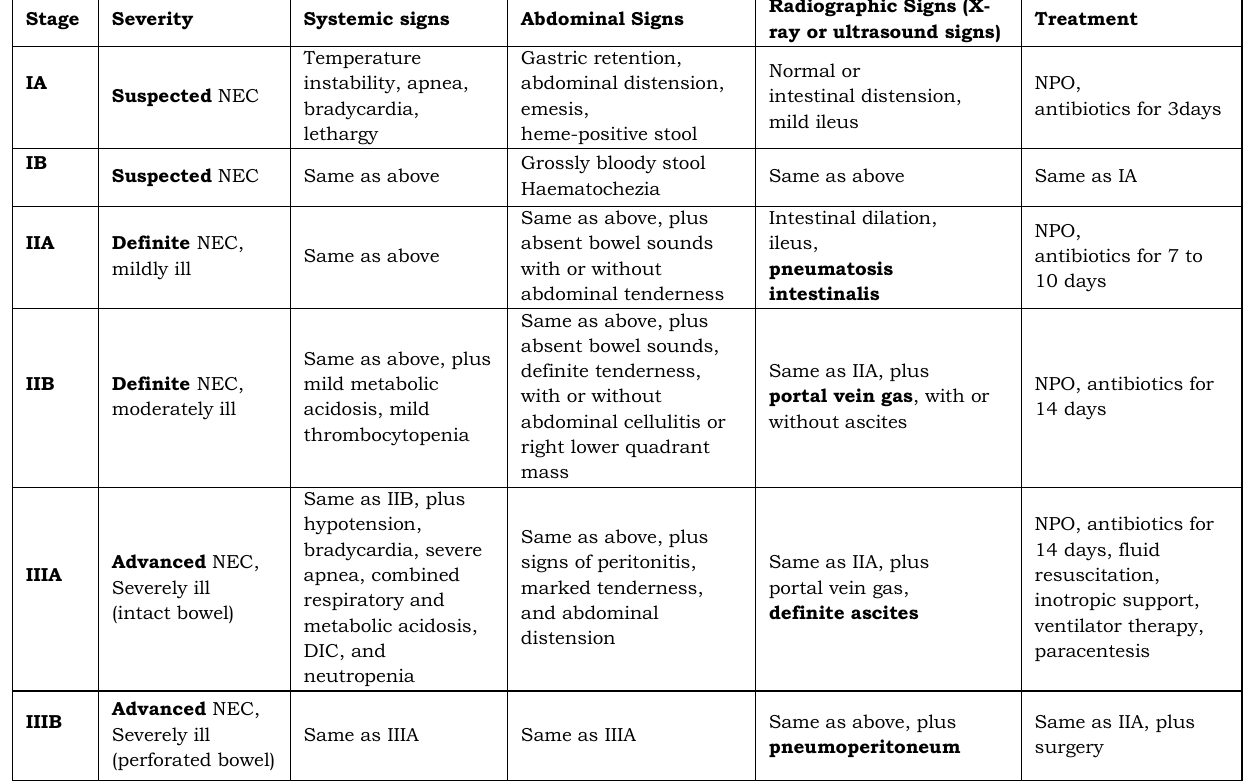
Table1: Modified Bell’s staging criteria for Necrotizing Enterocolitis (NEC) [DIC: disseminated intravascular coagulation; NPO: “nil per oral” or nothing by mouth]